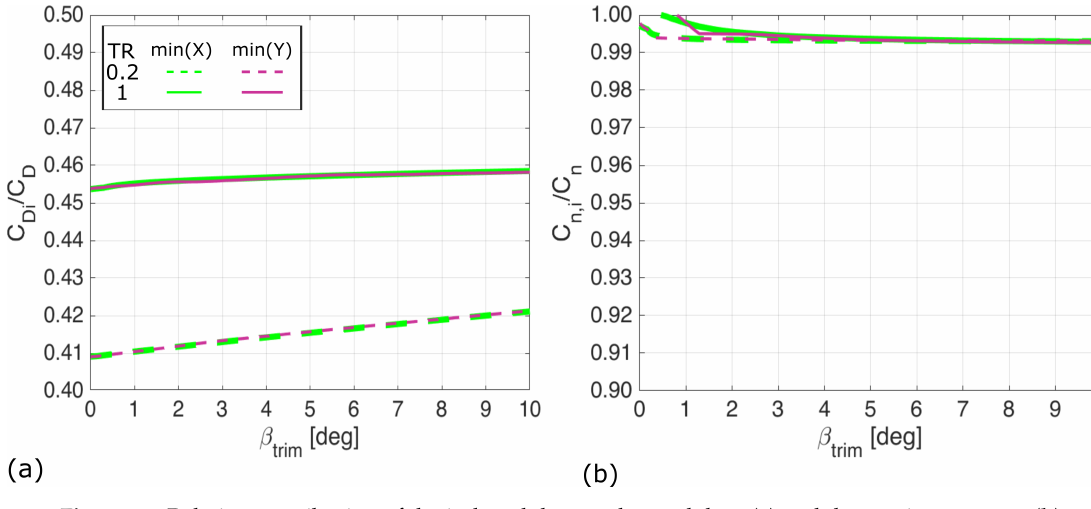
Figure 13. Relative contribution of the induced drag to the total drag ( a ) and the yawing moment ( b ) for the 45 degree swept wing. In all cases, the induced drag is responsible for over 99% of the yawing moment produced by this method. This is despite the total drag comprising over 50% profile drag.